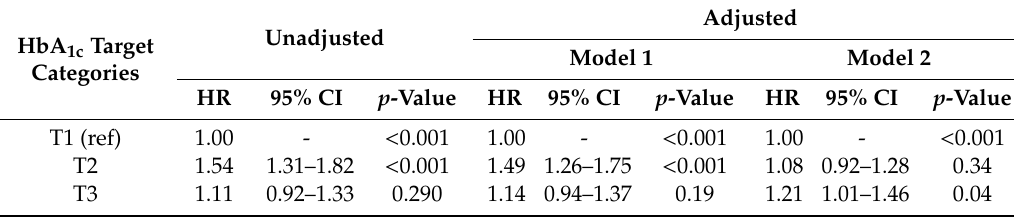
Table 4. Mortality risk by HbA 1c target categories among participants not treated with agents causing